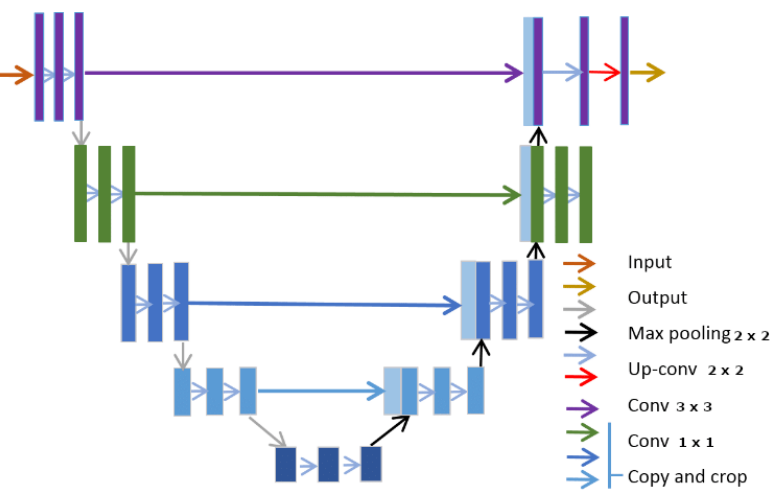
Figure 6. U-net architecture.